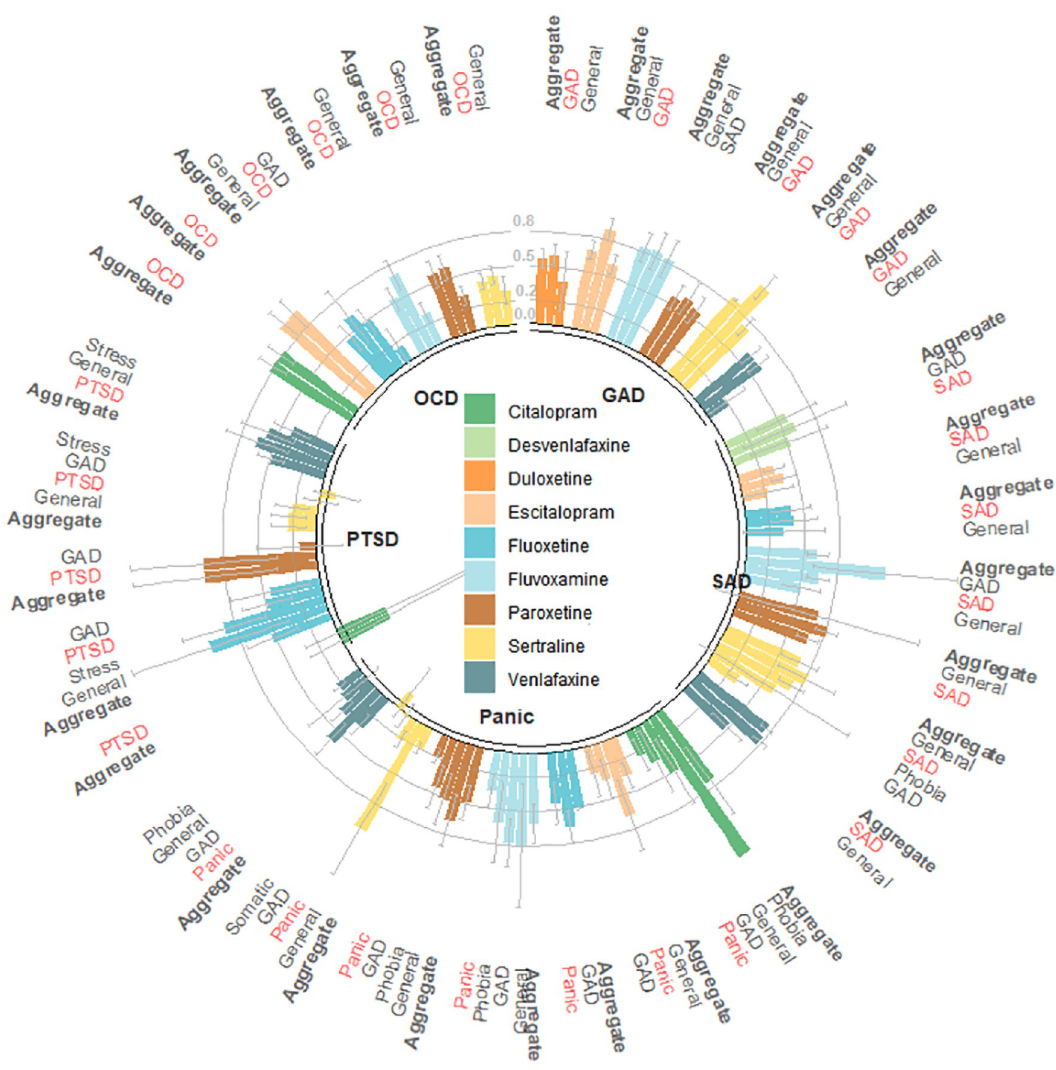
Fig 1. Standardized mean differences (SMDs) in the studied symptom domains within the 5 diagnoses. GAD, generalized anxiety disorder; OCD, obsessive-compulsive disorder; PTSD, post-traumatic stress disorder; SAD, social anxiety disorder. Patients’ diagnoses are presented in the center of the circular bar plot, and symptom domains are described outside. Effect sizes are presented as SMDs, and error bars represent estimated standard errors. SMDs related to the primary outcome (i.e., aggregate measure of the available symptom domains evaluated in patients within the same diagnosis) are highlighted in bold, and SMDs related to symptom domains that are concurrent with patients’ diagnosis are highlighted in red. Outcome measures classified as general represent scales designed to assess overall